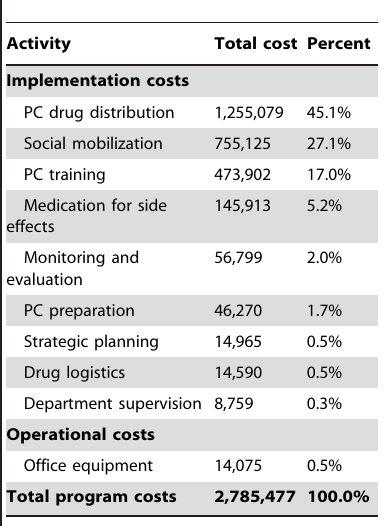
Table 3. Haiti activity costs (in $ ,